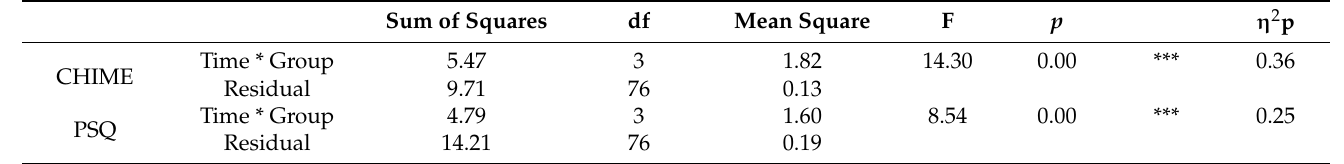
Table 4. Sample 1 and 2 post hoc comparison for PSQ score to test effect equivalence. Table 3. Repeated Measures ANOVA to test effect equivalence for PSQ and CHIME. Sum of Squares